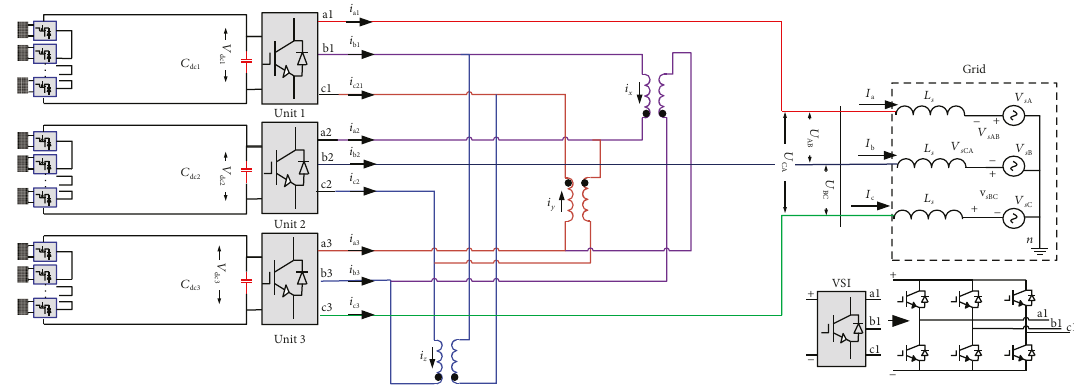
Figure 4: Three-phase cascaded VSI using coupled